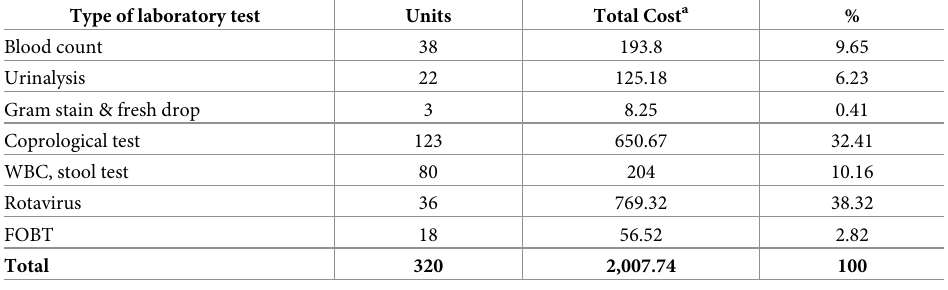
Table 5. Cost by type of laboratory